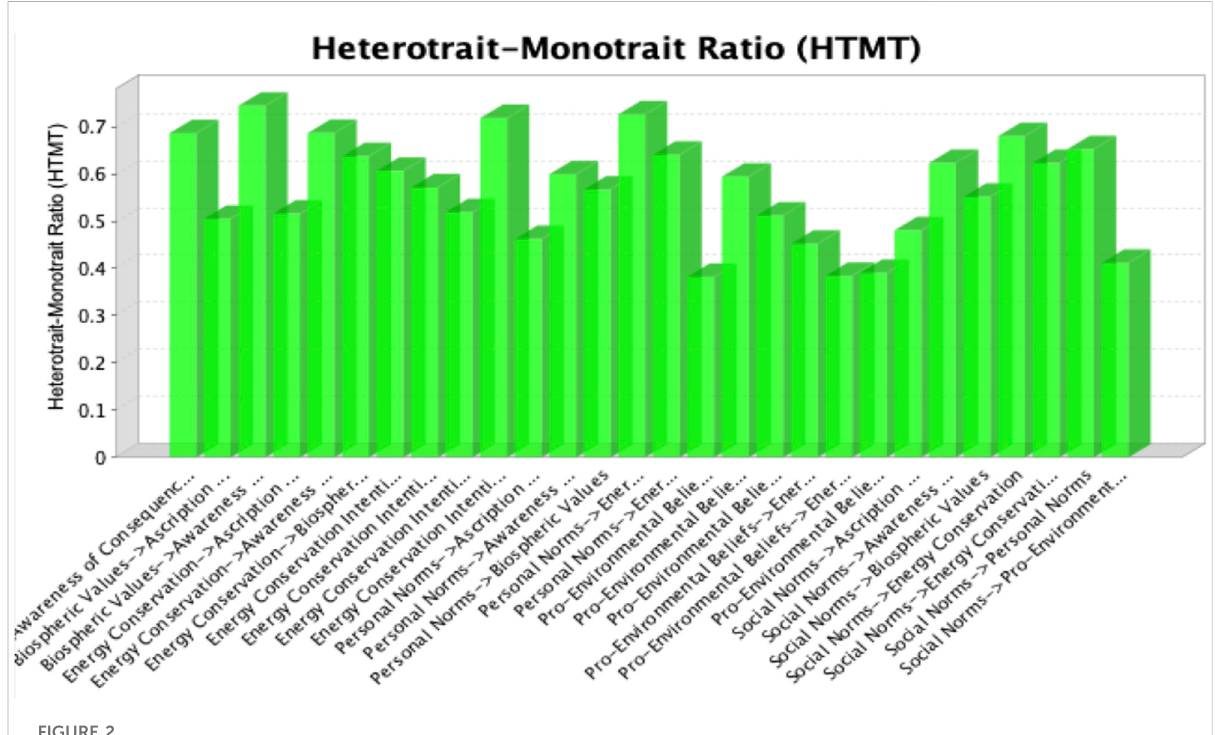
FIGURE 2 Heterotrait-monotrait ratio (HTMT).